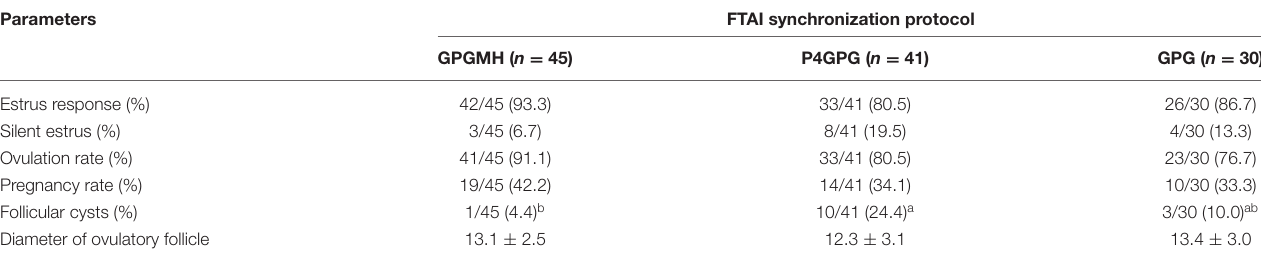
TABLE 5 | Comparison of estrus, ovulation, and pregnancy rate of buffaloes synchronized by GPG, GPGMH, and P 4 GPG protocols during breeding season. Parameters